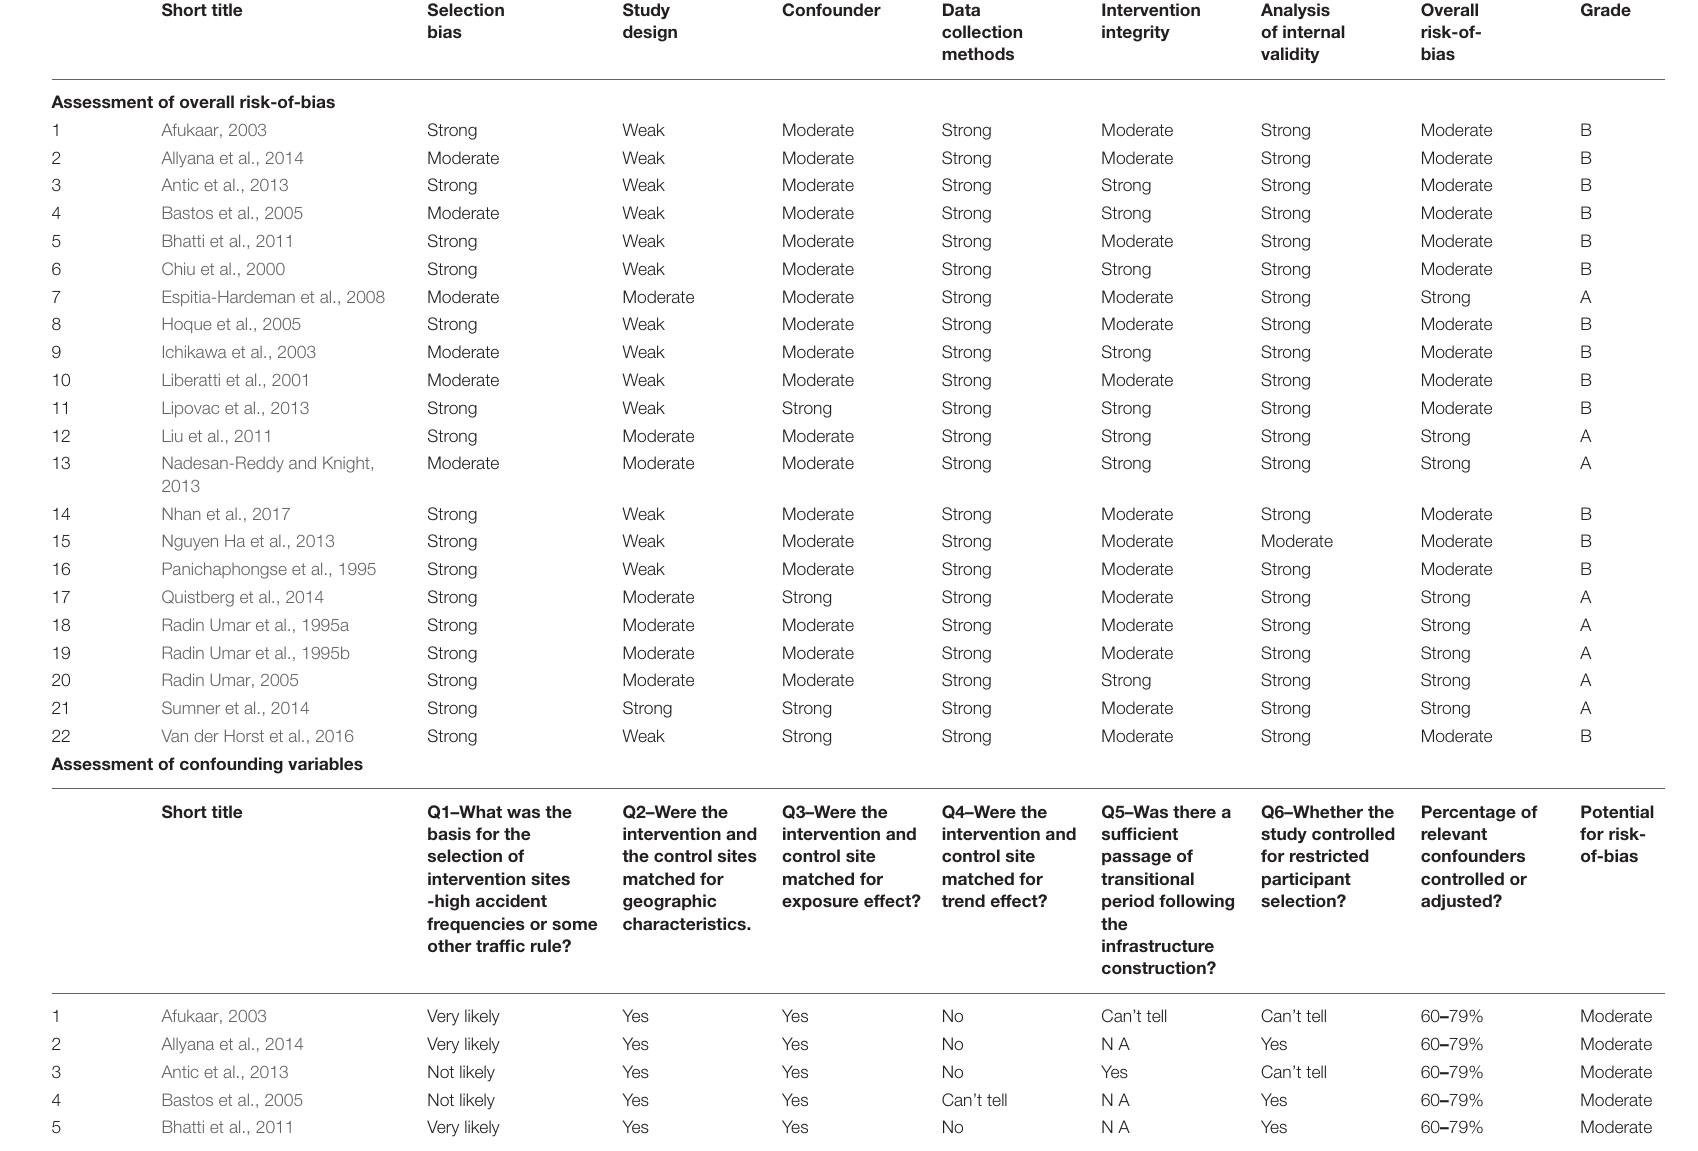
TABLE 2 | Assessment of risk-of-bias of studies included for analysis based on